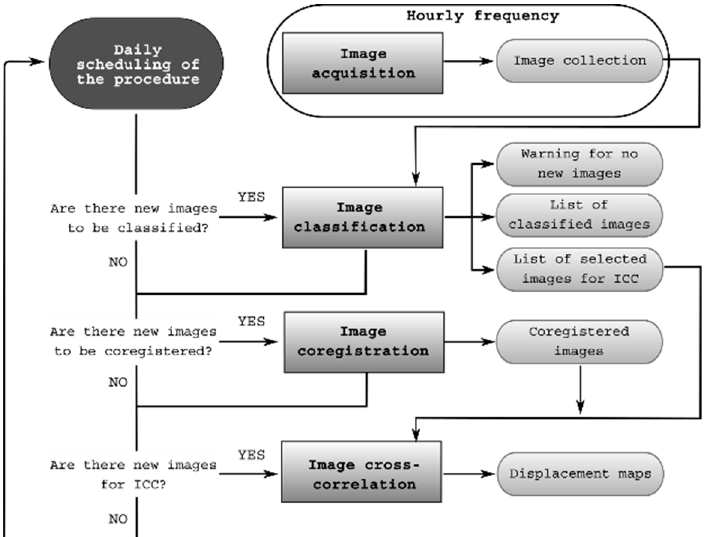
Figure 2. Workflow of an automated procedure used in image cross-correlation (ICC) applications.